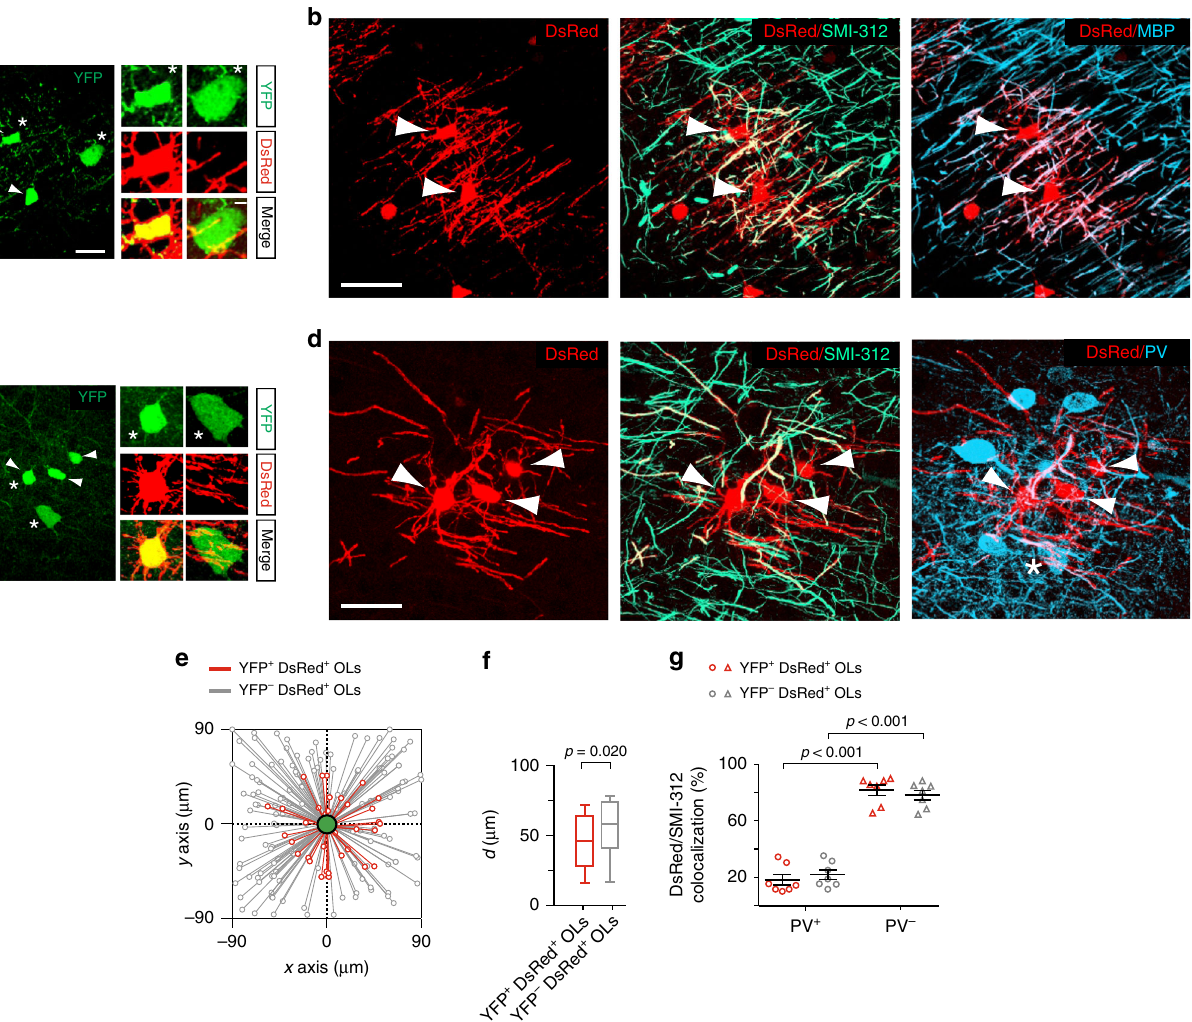
Fig. 4 Dbx1-derived OLs myelinate axons of PV + and PV − neurons in cell clusters. a , c Confocal images of two YFP + cell clusters composed of YFP + / DsRed + OLs (white arrowheads) and YFP + interneurons at PN19 in the somatosensory cortex of Dbx1 CRE ;Rosa26 YFP ;PLP DsRed mice. Insets: magni fi cation of a YFP + /DsRed + OL and a YFP + interneuron of the same clusters (asterisks). Scale bars: 25 and 5 µ m. b The DsRed + branches of OLs belonging to the cluster in a (top, white arrowheads) co-localize with the axonal marker SMI-312 (middle) and MBP (bottom), con fi rming that these cells are myelinating cells ( n = 24 fi rstOLs from n = 3 mice). d The DsRed + branches of OLs belonging to the cluster in c (top, white arrowheads) co-localize with the axonal marker SMI-312 (middle) and PV, the speci fi c marker of FSI (bottom), con fi rming that some branches myelinate PV + interneurons. The asterisk indicates the soma of the PV + /YFP + interneuron in the cluster (mean area occupied by YFP + /DsRed + OL: 13419 ± 698 µ m 2 ; mean diameter: 155.57 ± 7.88 µ m; n = 9 from 9 clusters). Scale bars in b and d : 50 µ m. e Spatial distribution of YFP + /DsRed + OLs (red) and YFP − /DsRed + OLs (gray) with respect to YFP + interneurons (green) in YFP + cell clusters ( n = 22 clusters). Note the shorter intersomatic distances for OLs and interneurons from the Dbx1 lineage, but the lack of a speci fi c orientation of OLs. f Box plots of distances ( d ) of YFP + /DsRed + OLs (red) and YFP − /DsRed + OLs (gray) to YFP + interneurons (mean intersomatic distance: 44.2 ± 3.5 µ m for n = 33 YFP + /DsRed + OLs compared to 53.5 ± 2.1 µ m for n = 99 YFP − /DsRed + OLs, respectively, in 22 clusters; Mann – Whitney U test; signi fi cant p -value is indicated). Boxes show interquartile ranges and medians; whiskers indicate 10% and 90% percentile values. g Dot plots of percentages of PV + and PV − axons co-localizing with SMI-312 and DsRed + branches of YFP + /DsRed + OLs (red; n = 7 clusters from 3 mice) and YFP − /DsRed + OLs (gray; n = 7 clusters from 3 mice) (two-way ANOVA, F = 0.978 and DF = 1; signi fi cant p -values are indicated). Data in g are presented as mean ±